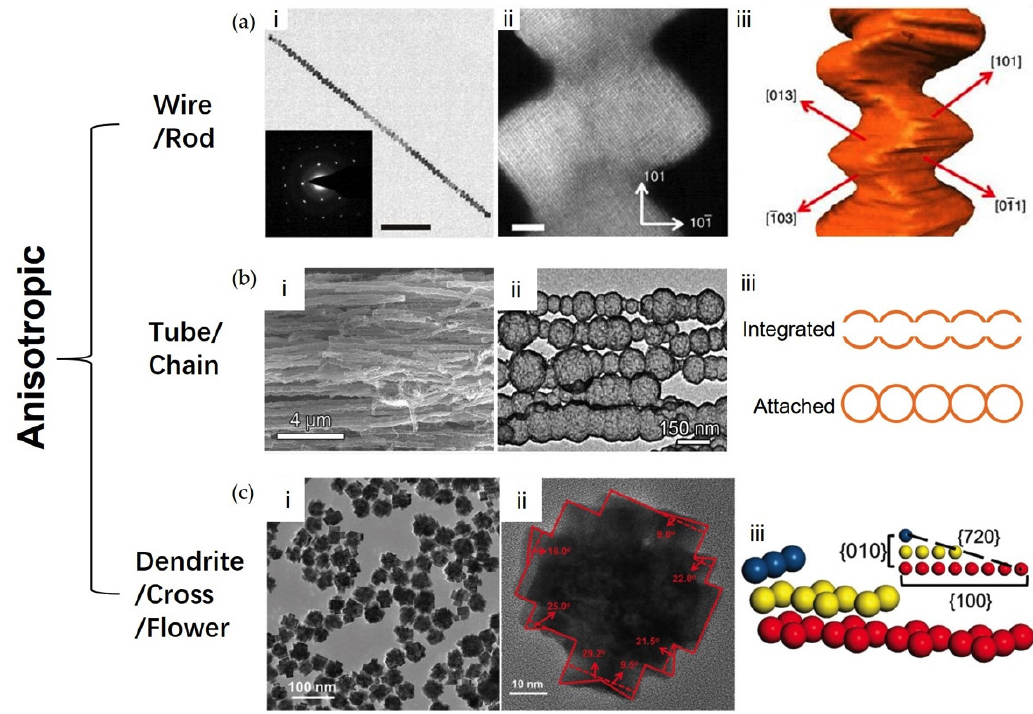
Figure 5. Three typical morphologies of anisotropic structure: wire/rod, tube/chain, and dendrite/cross/flower. ( a ) i. TEM and ii. HAADF-STEM images of hierarchical CoPt nanowires; iii. indexes of the exposed facets of CoPt nanowires; ( b ) SEM and TEM images for hollow FePt nanochains. Different synthetic route led to different types of nanochains; ( c ) i. TEM and ii. HRTEM image of crossed CoCuPt; iii. Atomic illustration of {720} facet associated with the angle 29.2° shown in ii. Images and model in ( a ) were reprinted with permission from reference [26]. Copyright 2016 Nature Publishing Group. Images in ( b ) were reprinted with permission from reference [21]. Copyright 2016 Royal Society of Chemistry. Images and model in ( c ) were reprinted with permission from reference [69]. Copyright 2018 John Wiley and Sons.